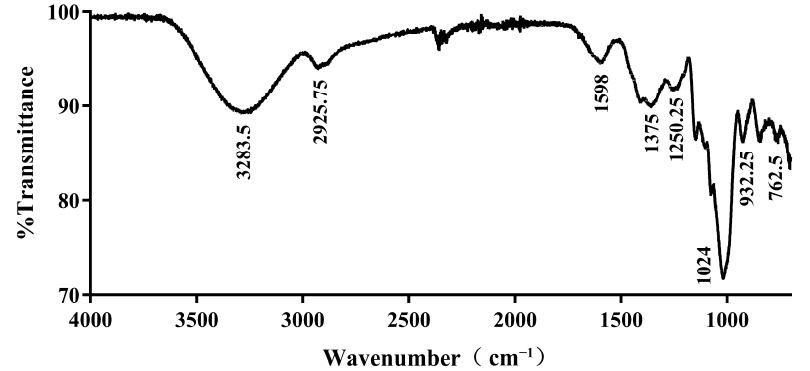
Figure 2 . FT-IR spectra of